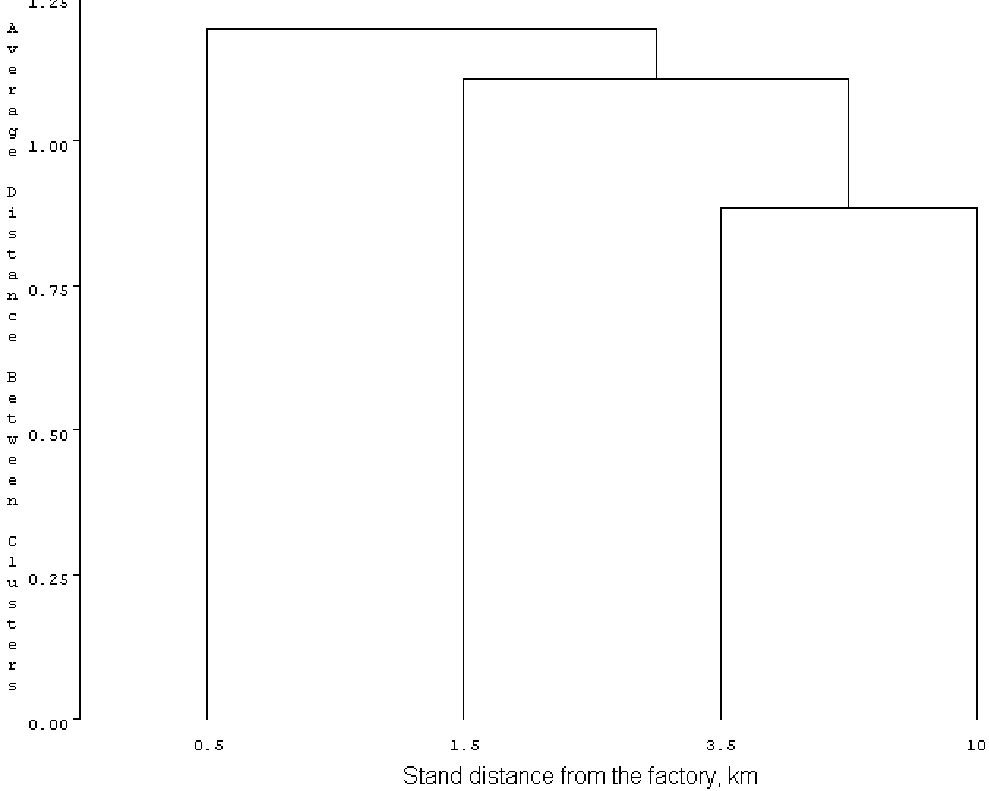
FIGURE 4 . Grouping of Scots pine ( P. sylvestris L.) stands growing at different distances from the cement factory according to percentage composition (n = 4) of the components (71) of essential oils in current-year needles (July 10,